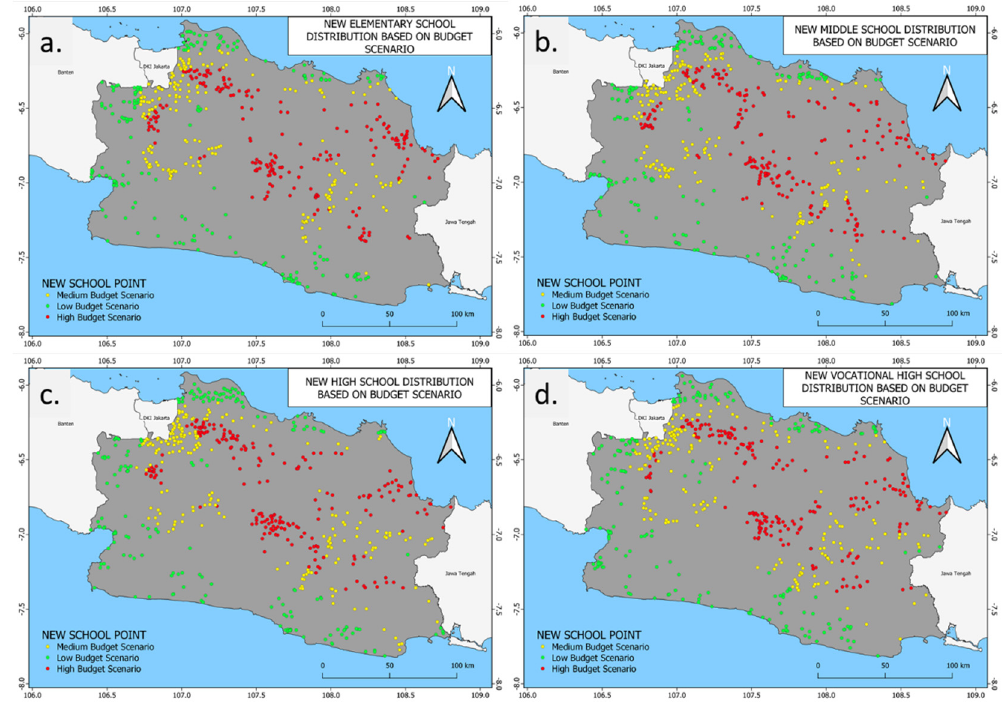
Figure 14. Distribution of new schools by budget scenario: ( a ) elementary, ( b ) junior high, ( c ) senior high, and ( d ) vocational high schools.